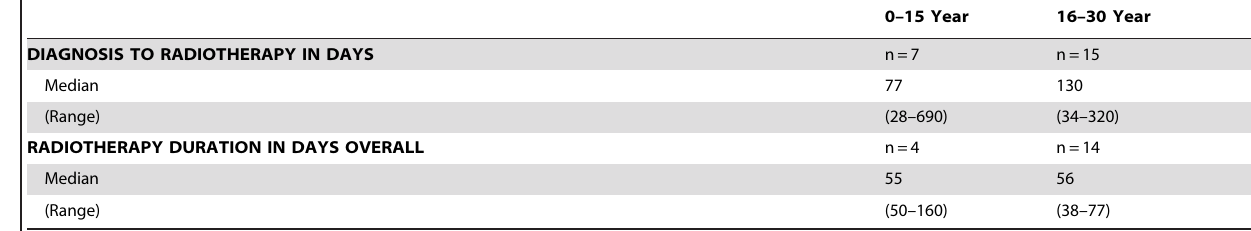
Table 3. Radiotherapy treatment.